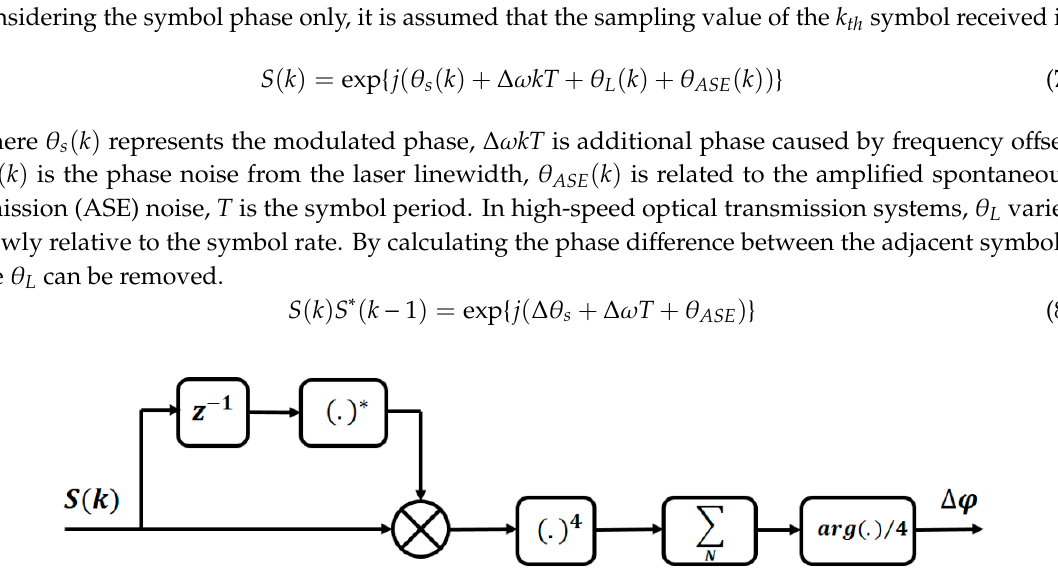
Figure 3. Block diagram of the frequency estimator.